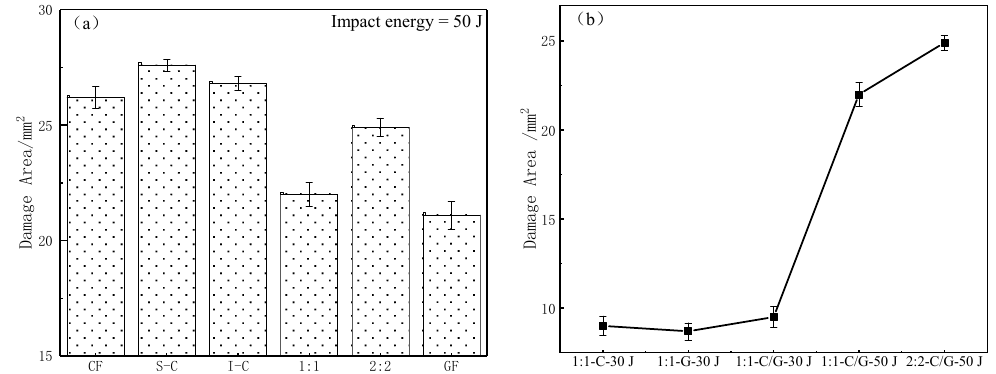
Figure 11. Damage area of ( a ) various composite specimens after 50 J impact and ( b ) intralayer composite